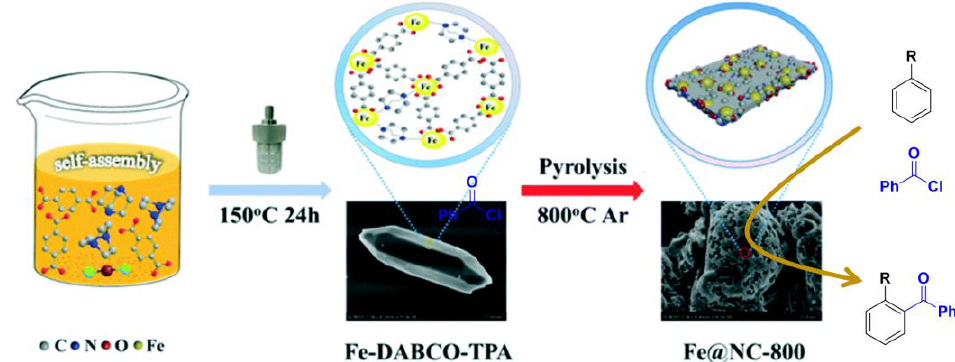
Figure 18. Schematic diagram of the synthesis of Fe@CN-800 and its catalyzed acylation reaction. Reprinted with permission from Ref. [94]. Copyright 2019, Royal Society of Chemistry.